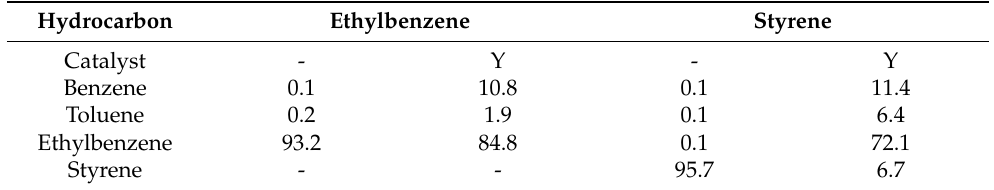
Table 7. The product distribution of ethylbenzene and styrene reaction at 550 ◦ C and WHSV 85 h − 1 .